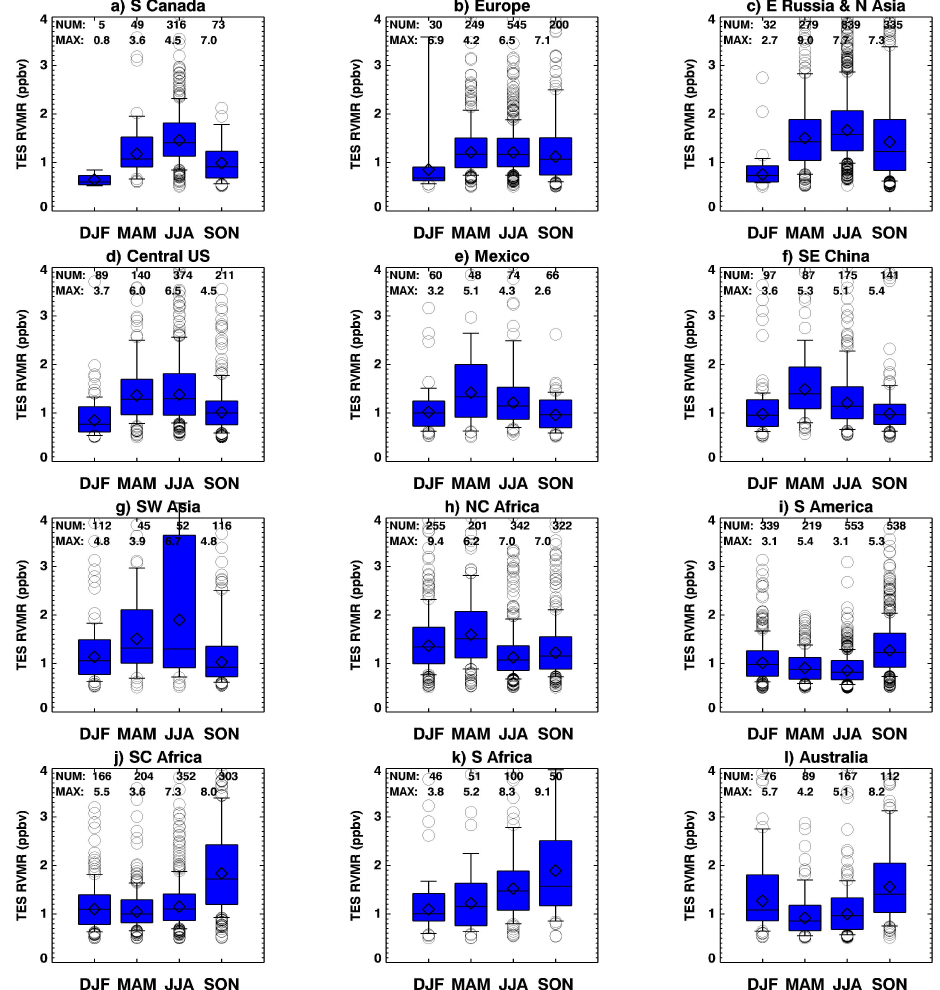
Fig. 13. Statistics of the TES CH 3 OH RVMR values in Fig. 11 for each region in Fig. 12. Boxes show the 25th and 75th percentiles, the line and diamond show the median and the mean, the whiskers show the 10th and 90th percentiles, and the outliers are indicated by the